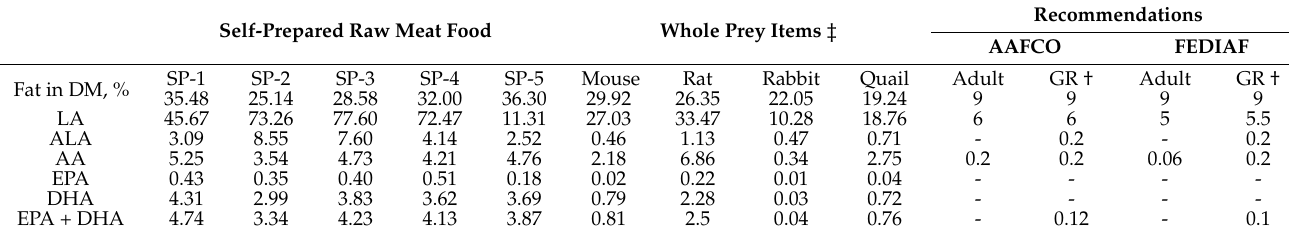
Table 3. Concentrations of crude fat (%), essential and conditionally essential fatty acids (EFA) (g/kg DM) in self-prepared foods, whole prey items, American Feed Control Officials (AAFCO) and United States and the European Pet Food Industry Federation (FEDIAF) recommendations.